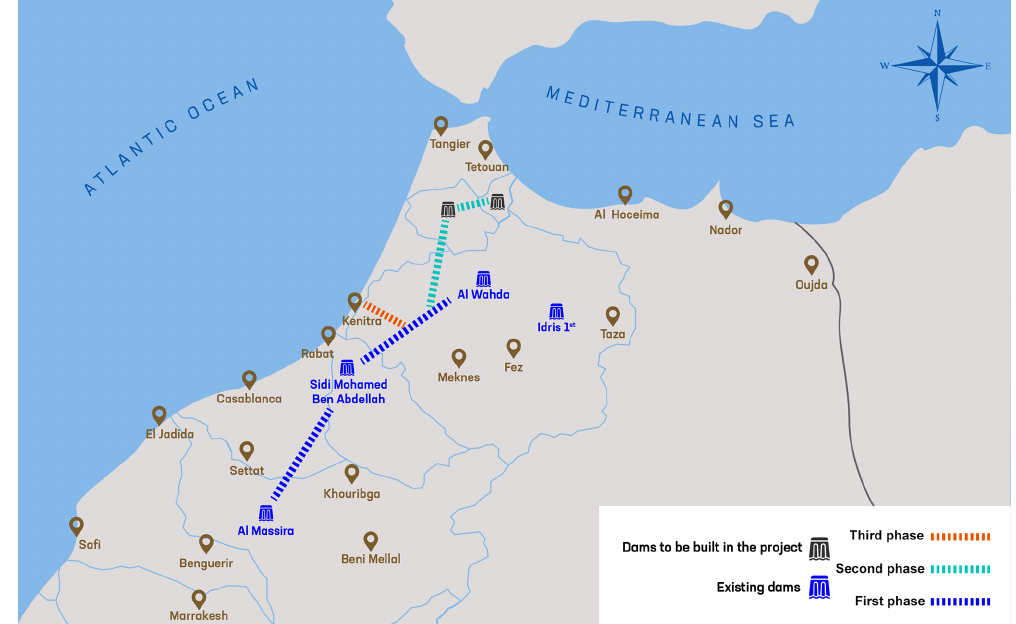
Figure 2. The planned water transfer